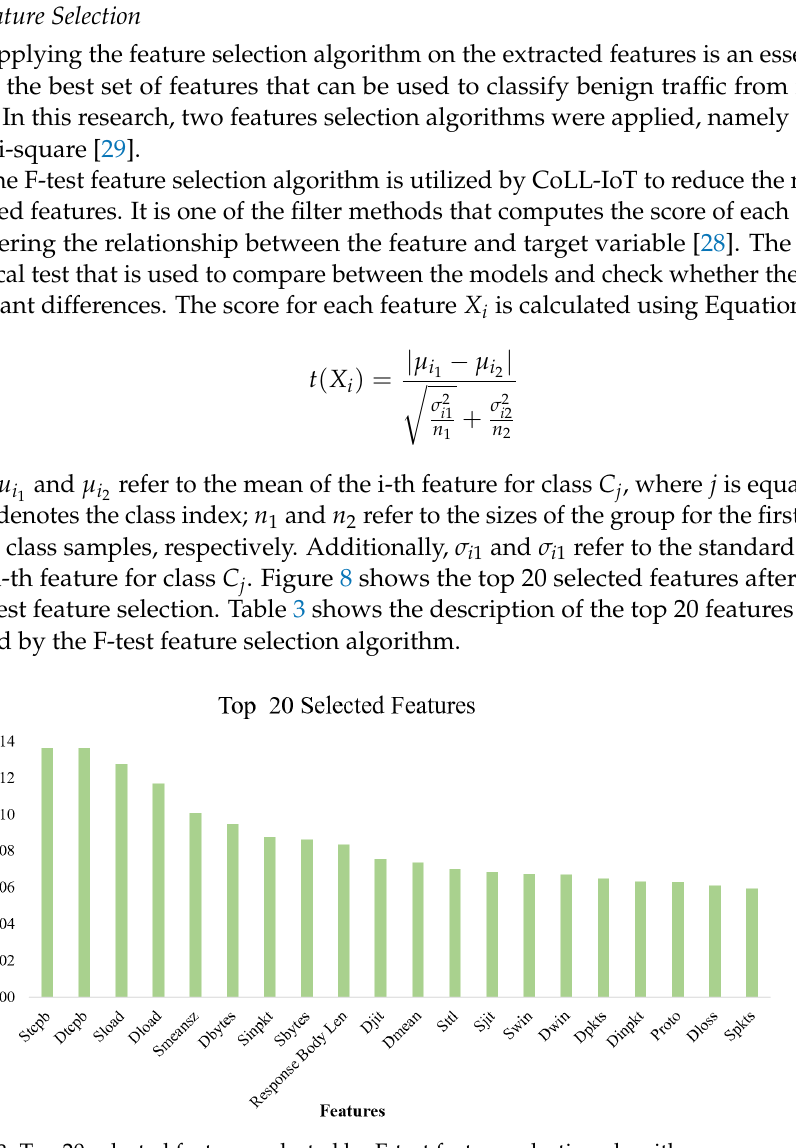
Figure 8. Top 20 selected features selected by F-test feature selection algorithm.